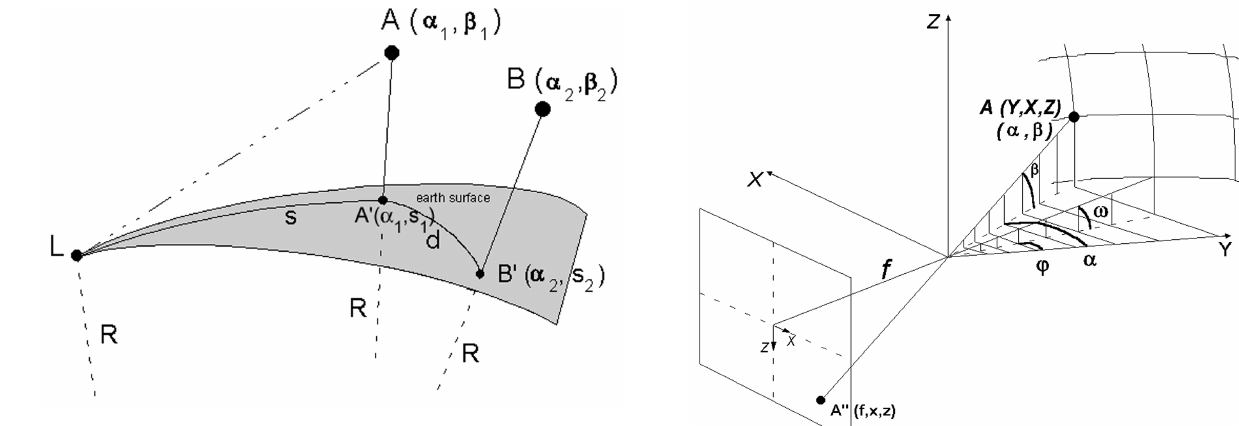
Fig. 4. Position of the NLC point A and its projection (A 00 ) to the NLC